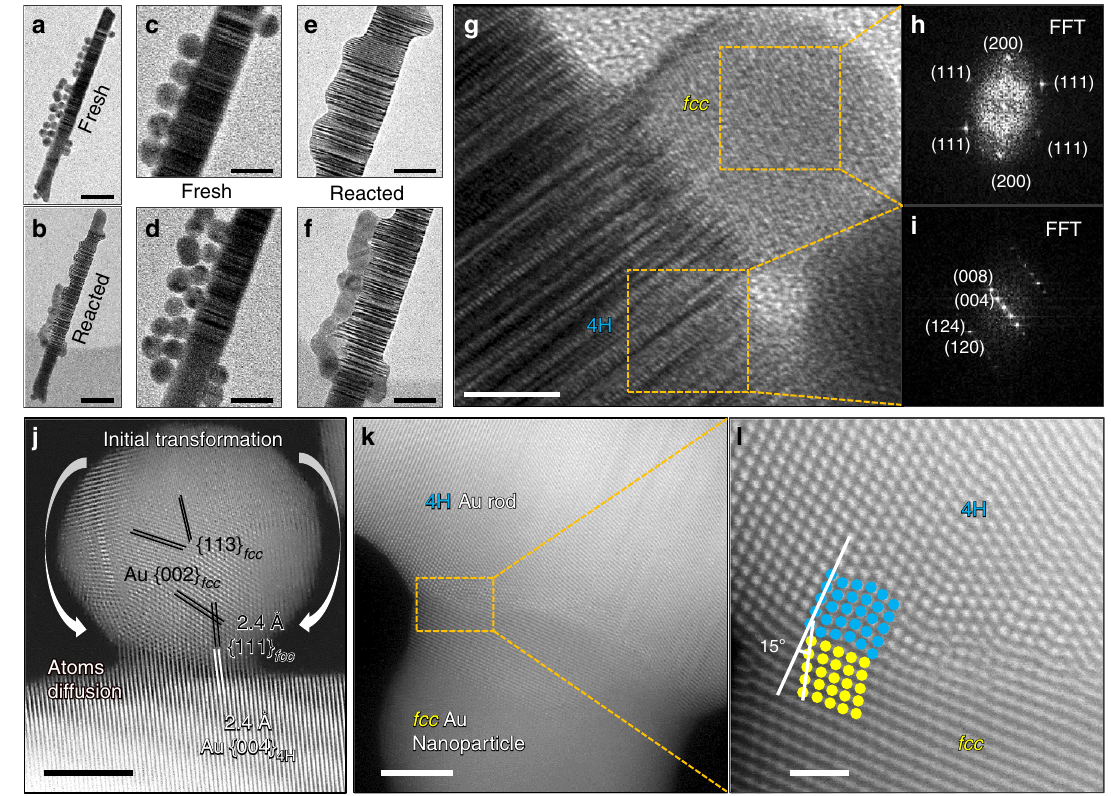
Fig. 2 Orientation relationship between the fcc nanoparticles and 4H rod. a TEM image of original fresh fcc gold nanoparticles on a 4H/ fcc gold nanorod; b TEM image of the same region in a after reaction (the scale bar in a , b corresponds to 100 nm); magni fi ed TEM image of the top/bottom portion of the fresh sample ( c , d ) and reacted sample ( e , f ) (the scale bar in c – f is 20 nm); g high resolution TEM image showing the orientation relationship of the Au nanoparticle and 4H nanorod during reaction; h FFT of the square region at the fcc -Au nanoparticle h ; i FFT of the square region at the 4H rod; j – l atomic scale Z-contrast scanning TEM imaging of the interface between fcc gold nanoparticle and 4H-gold rod at the early stage of phase transformation; the {111} crystal planes of the fcc Au nanoparticle are well aligned with the (004) crystal planes of the 4H rod with a small 15° tilt angle (the scale bar in g , j – k is 5 nm; the scale bar in l is 1